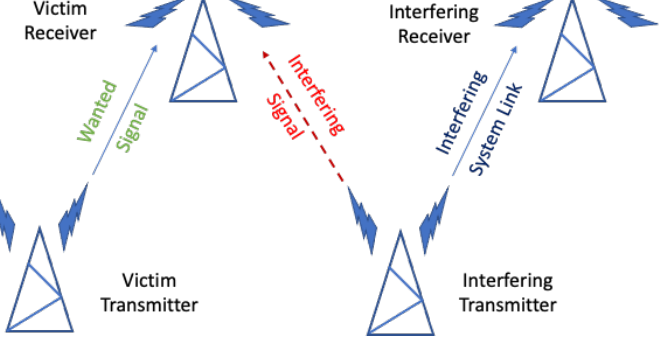
Figure 2. Schematic compatibility scenario and terminology used in SEAMCAT for the primary (victim) and secondary (interferer) links.